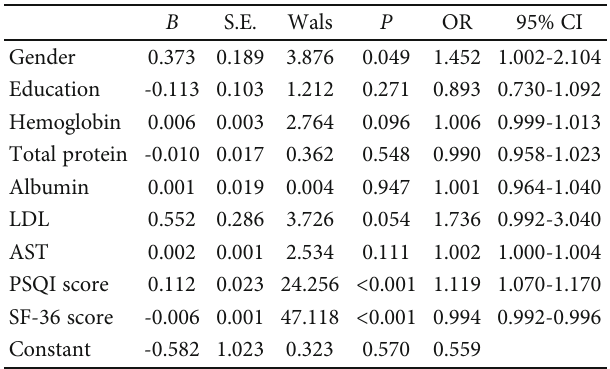
Table 8: Logistic regression of depression symptom-related factors in